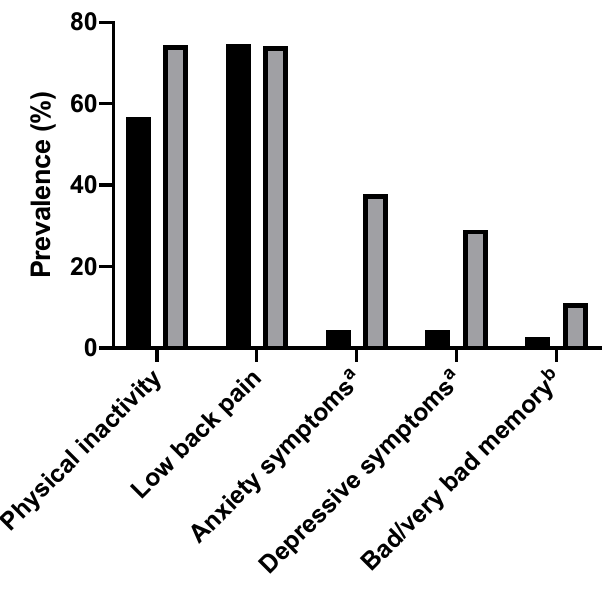
Figure 1. Physical and mental health characteristics of the sample before and during social distancing. Rio Grande do Sul, Brazil. N=2,321. a Moderate-to- severe symptoms. b Self- rated